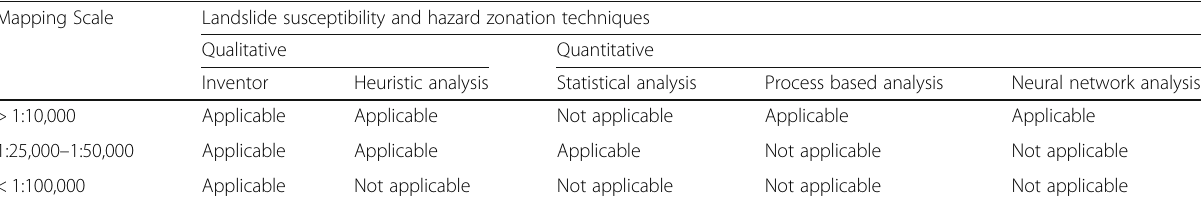
Table 1 Application of various landslide susceptibility and hazard zonation techniques at different scales (Modfied from Soeters and Van Westen 1996; Aleotti and Chowdhury